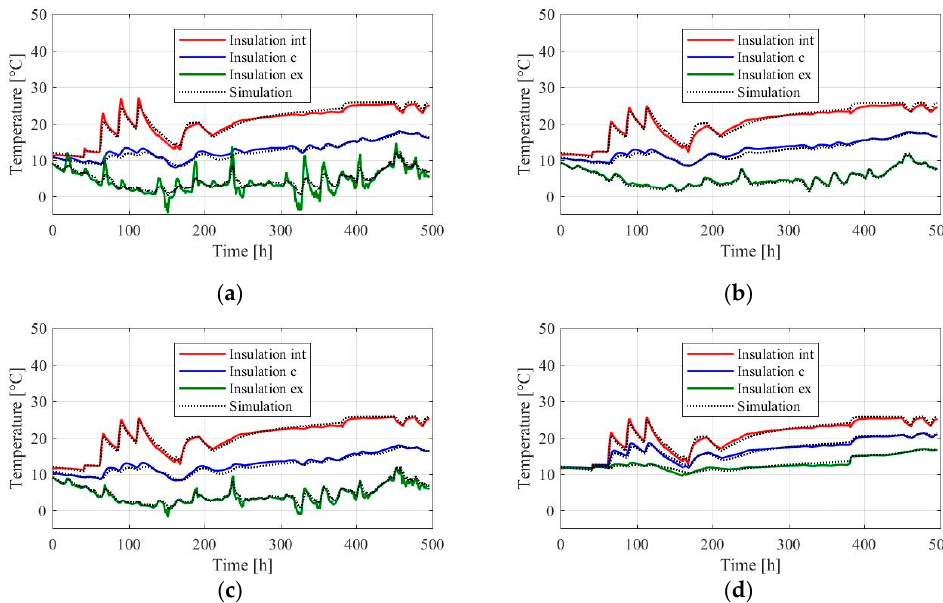
Figure 6. Measured and predicted layer temperatures for ( a ) ceiling, ( b ) floor, ( c ) exterior walls and ( d ) partition wall for internal insulation surface (Insulation int), insulation core (Insulation c) and external insulation surface (Insulation ex).